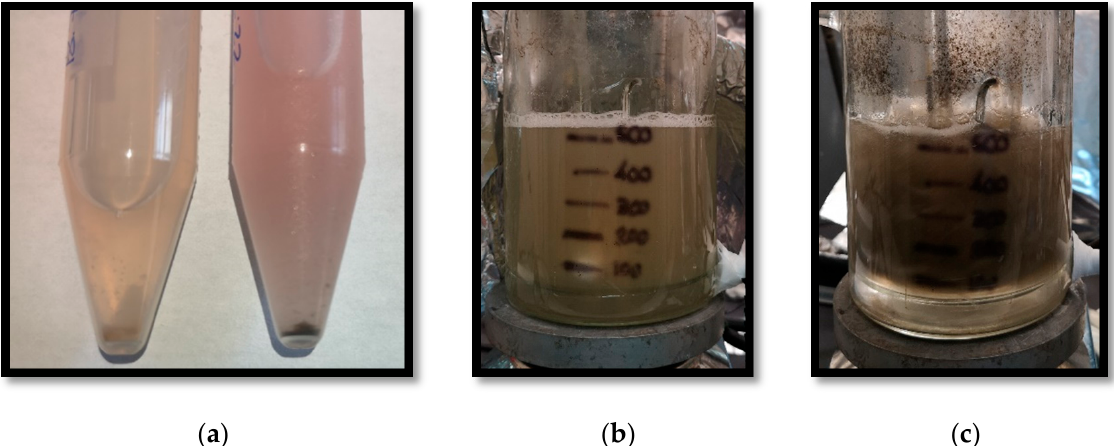
Figure 4. ( a ) Cells collected from the bioreactor at the beginning of Syngas B bioconversion by B. methylotrophicum ( left ) and at the end of the three pH 7.0 batch series ( right ); ( b ) culture media in the bioreactor at the end of the Syngas A bioconversion; ( c ) culture media in the bioreactor at the end of Syngas B bioconversion.